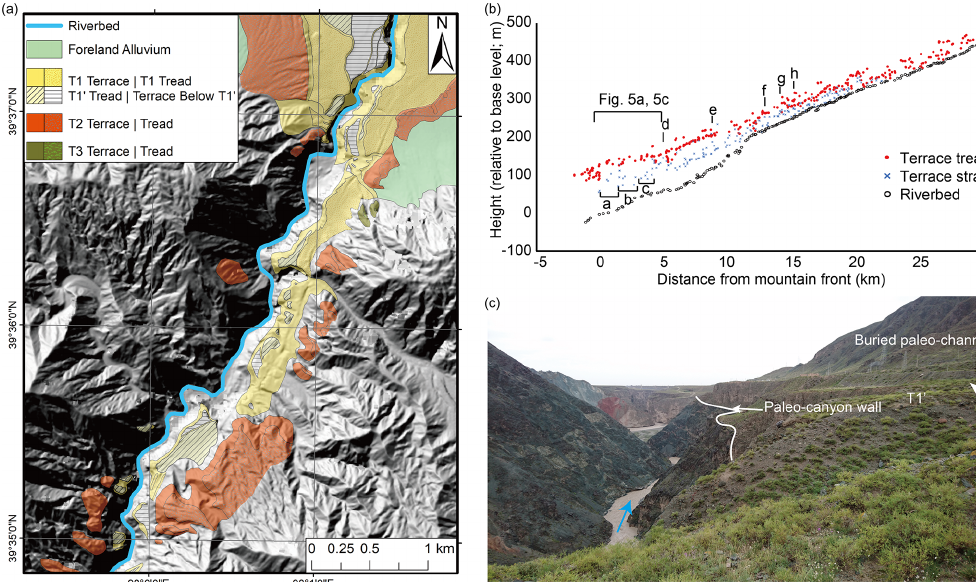
Figure 5. Bedrock incision and terrace preservation along the Beida River. (a) Terrace map of the lower reach of Beida River. T1 terraces are all preserved on the east side of the canyon. (b) Terrace profiles of Beida River. Letters correspond to reaches where terrace mapping indicates that the original paleocanyon is preserved and the river incised into the adjacent bedrock soon after the abandonment of T1’ (see Fig. S5). (c) Photo of the lower reach of Beida River, looking downstream, with paleochannel axis and paleocanyon wall annotated. Here the river incised mostly into bedrock along the west edge of the T1 terrace fill deposit.